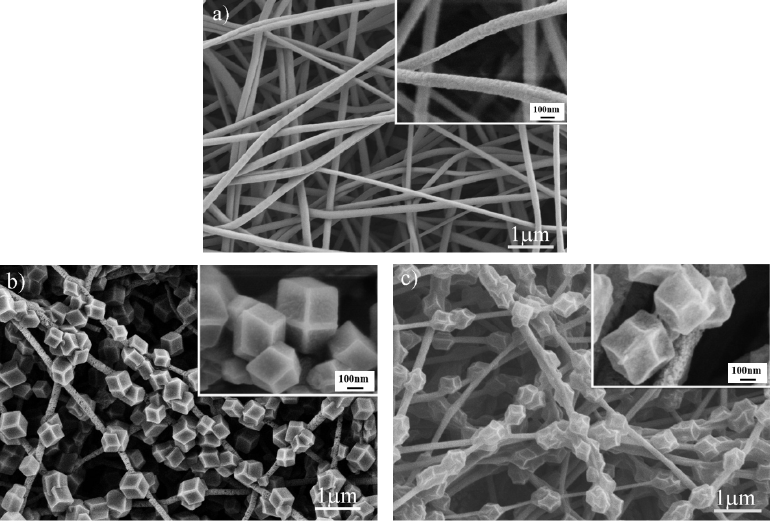
Figure 2. SEM images of original PAN electrospun nanofiber membrane ( a ), the ZIF−8@PAN nanofiber membrane ( b ), and the carbonized ZIF−8@PAN nanofiber membrane ( c ).